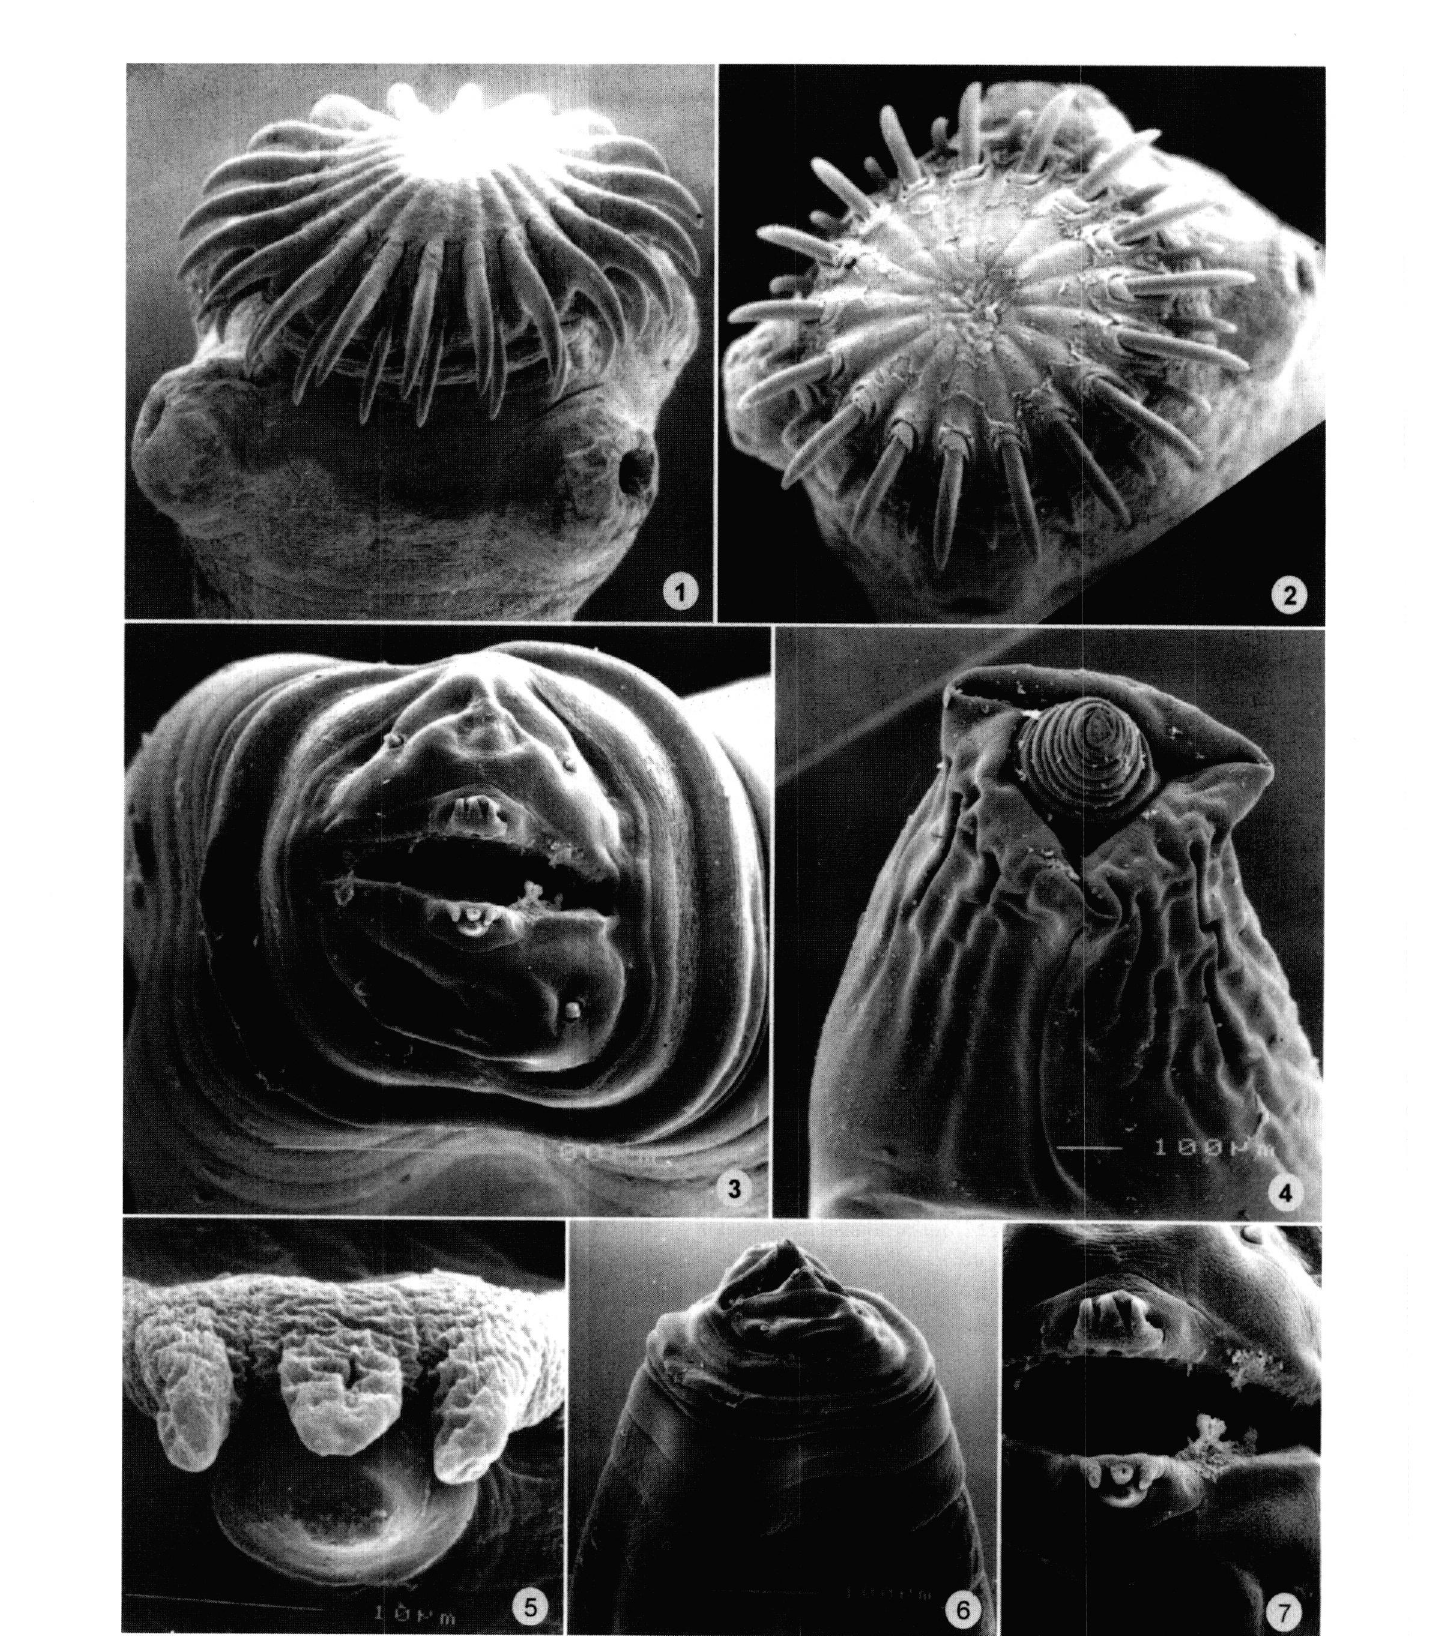
Figs 1-2. - Taenia taeniaeformis. 1. Scolex; subapical view. 2. Rostellum with hooks; apical view. Figs 3-7. - Physaloptera praeputialis. 3. Anterior end; apical view. 4. Posterior end of female; subapical view. 5. Detail of circumoral lips; apical view. 6. Anterior end; sub- ventral view. 7. Mouth region; apical view (SEM